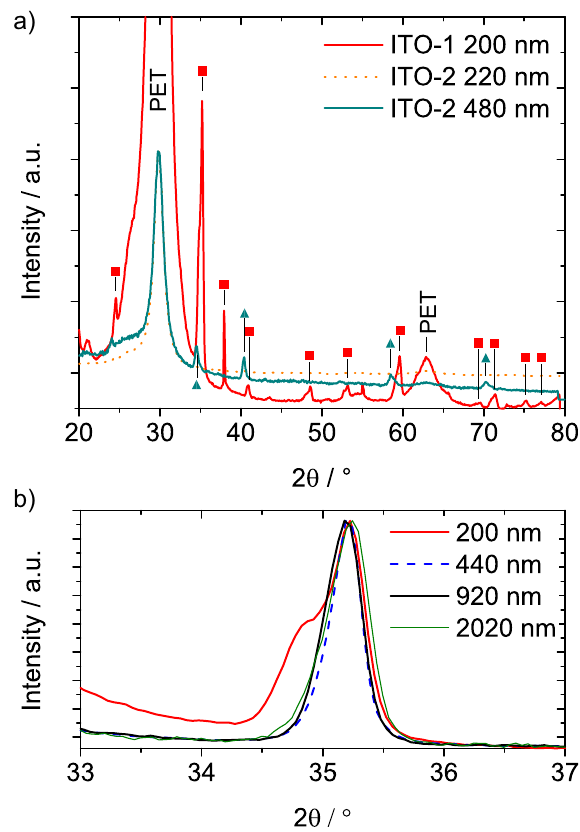
Figure 2. ( a ) X-ray diffraction patterns of representative ITO-1 and ITO-2 coatings. The peaks are assigned to the In 1.9 Sn 0.05 O 2.95 phase by filled squares and to the Sn(Sn 2 In 4 )O 12 phase by filled triangles; ( b ) (222)-diffraction peak of ITO-1 films with varying thickness. For a better comparison of the full width at half maximum (FWHM), the peaks are normalized to the maximum intensity of the (222) peak. For the 200nm film, the shoulder of the peak belongs to the Sn(Sn 2 In 4 )O 12 phase.